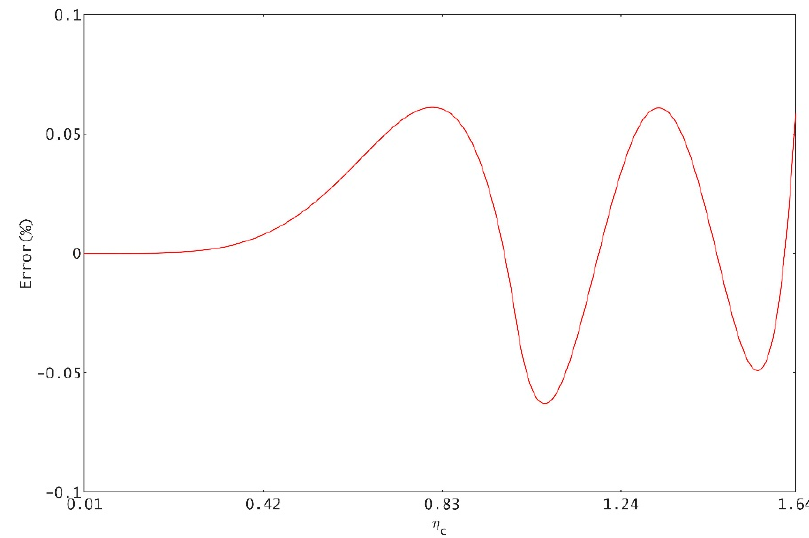
Figure 8. Error analysis of the critical depth formula for arched sections.